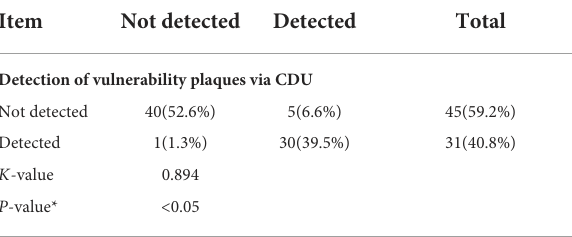
TABLE 5 Comparison of the consistency of CDU and HRMRI for the detection of vulnerability plaques ( N =